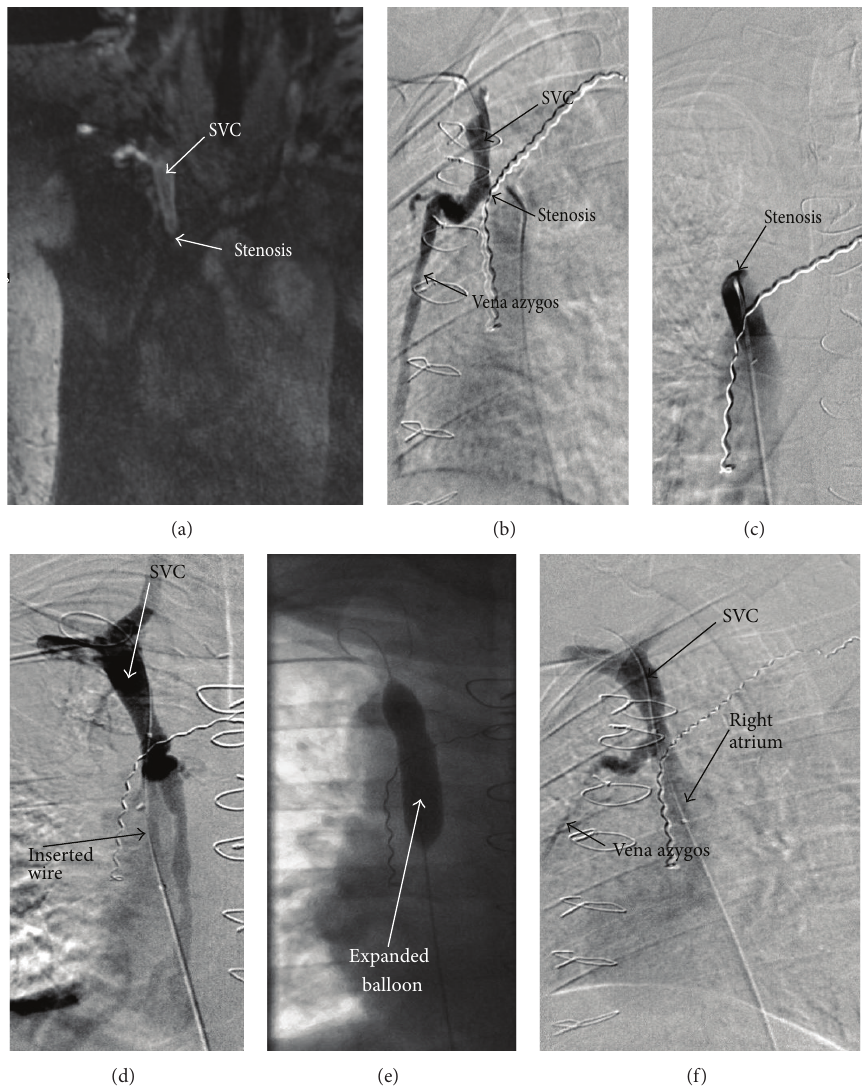
Figure 1: (a) Magnetic resonance tomography (MRT): breakup of the contrast medium in the superior vena cava (SVC) just before the right atrium. (b) Cavography depicted a subtotal stenosis of the SVC. Notably, the collateral contrast enhancement in the vena azygos. (c) Retrograde exposure of the SVC stenosis. (d) Successfully retrograde wire sounding of the SVC stenosis. (e) Effectively balloon-dilatation (maximum 10mm diameter). (f) Postinterventional cavography revealed a stenosis-free flow/passage into the right atrium. Noteworthy, the clear decline of the collateral contrast enhancement in the vena